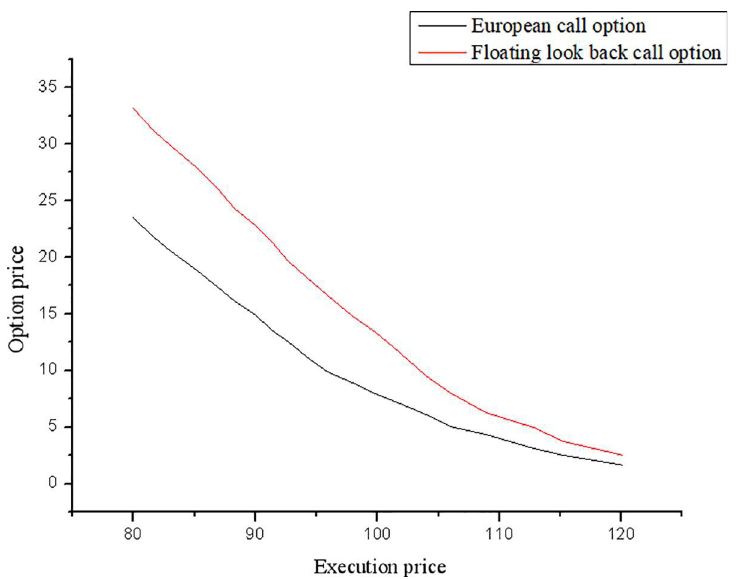
Fig 2. Simulation results of option